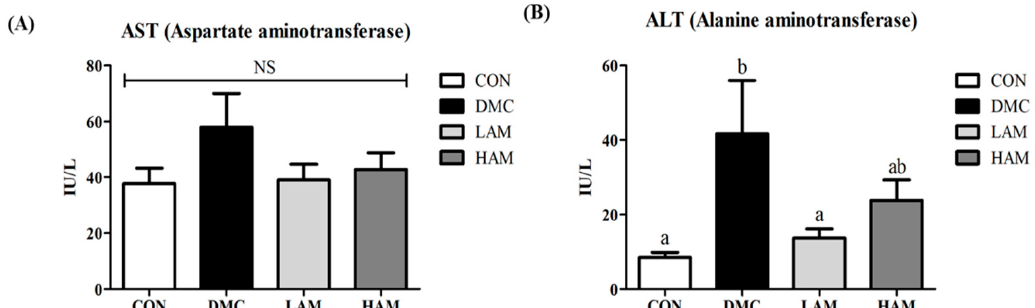
Figure 4. Effect of AME on hepatic damage related markers, ( A ) aspartate aminotransferase (AST) and ( B ) alanine aminotransferase (ALT) in T2DM mice All values are reported as mean and SEM. Values with the different superscript letter were significantly different ( p < 0.05; ANOVA with post-hoc Duncan’s multiple range test). n = 10~11 mice in each group CON, normal control group (negative control); DMC, type 2 diabetic control group (positive control); LAM, diabetic group supplemented with low dosage (50 mg/kg BW) of AME; HAM, diabetic group supplemented with high dosage (100 mg/kg BW) of AME.